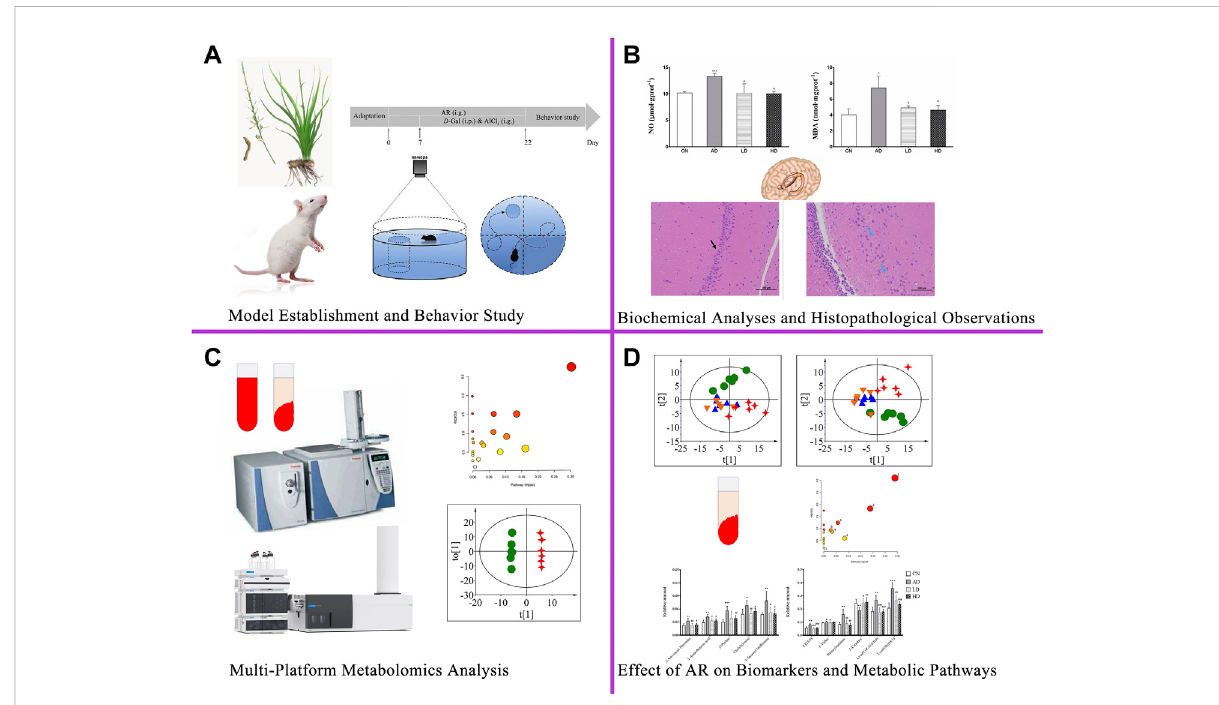
FIGURE 1 The work fl ow for therapeutic effect and mechanism analyses of AR on Alzheimer ’ s disease. AR: Anemarrhenae Rhizoma